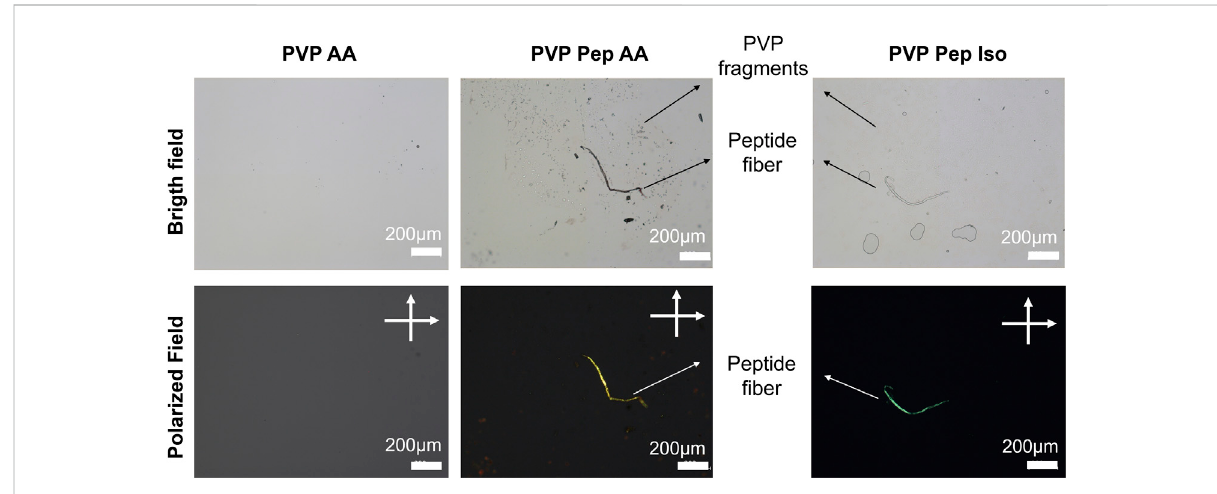
FIGURE 3 Microscopic observation of PVP and peptide fi bers dissolution and staining with Congo Red in bright and polarized fi eld (cross polarized at 90 ° angle).